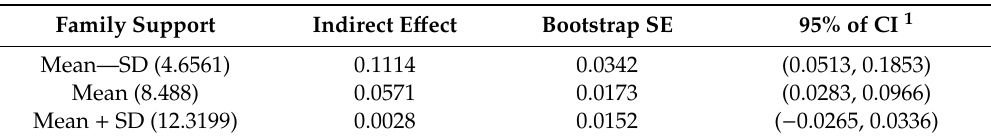
Table 4. Moderated indirect e ff ect of bullying victimization on sedative / hypnotic use divided into three levels of family support.